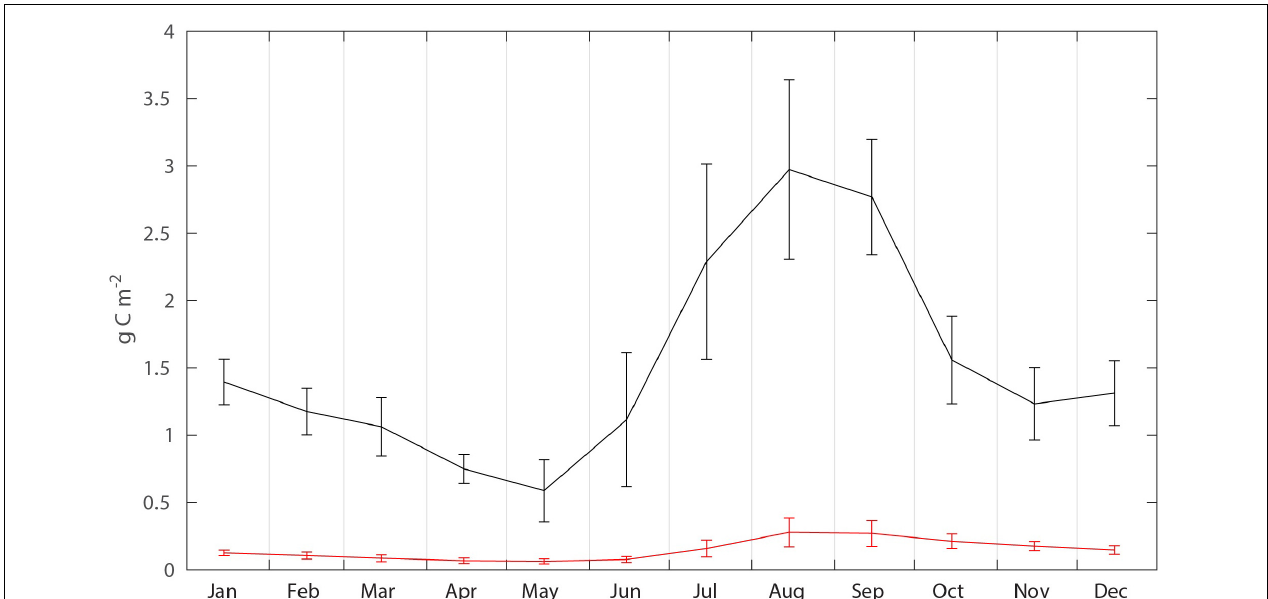
FIGURE 5 | Average seasonal (2005–2015) C. finmarchicus (black) and C. glacialis (red) biomass (g C month − 2 ) in the box, with monthly standard deviations.